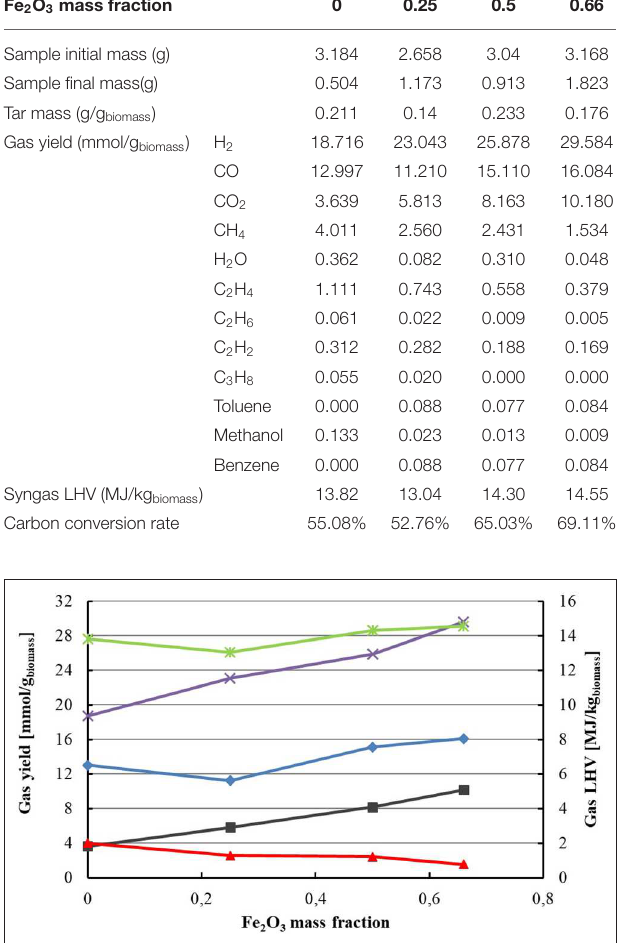
TABLE 3 | Gas yields through gasification of biomass with Fe 2 O 3 at 1,050 ◦ C as a function of the oxidant mass fraction.